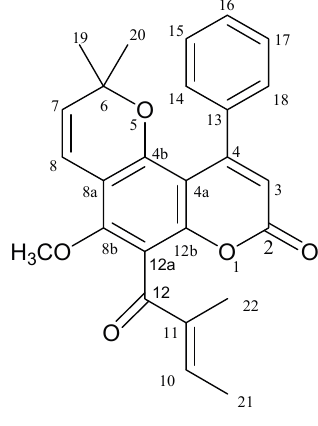
Figure 1. Structure of